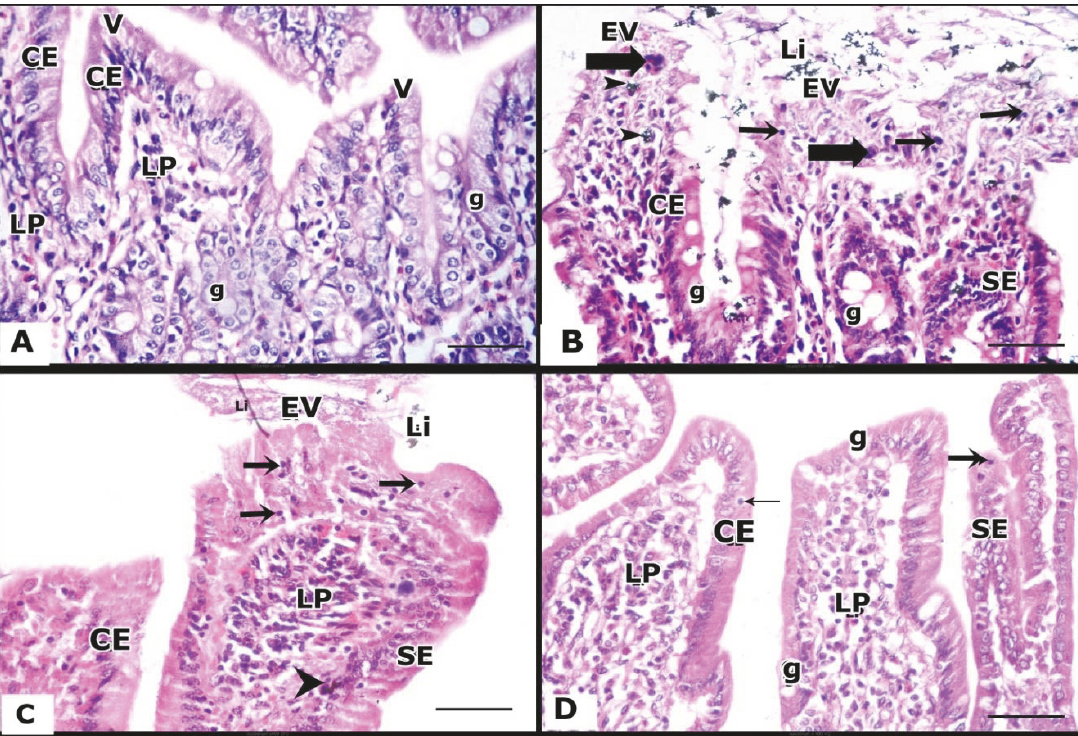
Figure 1: Representative photographs of the histologic sections of intestinal duodenal tissues obtained from the studied groups. A: The duodenal tissues of control group show normal histological architecture, while villi appear as a finger like projections with pointed ends (V) lined by a single layer of columnar epithelium with basal oval nuclei ( CE) , few goblet cells (g), and lamina propria ( LP ) with few cellular elements can be seen. B: The duodenal tissues of iron-overloaded group. The villi show loss of epithelial lining, abundant intraepithelial lymphocytes ( arrow ), iron deposit (arrow head), and giant cells ( thick arrow ) at their tops. Numerous goblet cells are also observed ( g ). Villi are also showing area of single epithelial columnar layer ( CE ) and areas of stratified epithelial lining ( SE ). Luminal iron ( Li ) overeroded villi ( EV ) are seen. C: Duodenal tissues of iron +DFO treated group show an eroded villus ( EV ) with area of single epithelial columnar layer ( CE ) and another part shows stratified epithelial lining ( SE ). Prominent lamina propria ( LP ) with iron deposit ( arrow head ) and demarcated intraepithelial lymphocytes ( arrow ) are clarified. Luminal iron ( Li ) is noticed. D: Duodenal tissues of iron + Quercetin-treated group show villi with area of single columnar layer with basal oval nuclei ( CE ) and small part shows stratified epithelial lining ( SE ). Prominent lamina propria ( LP ) with demarcated intraepithelial lymphocytes ( arrow ) and goblet cell ( g ) are clarified. (H&E ×